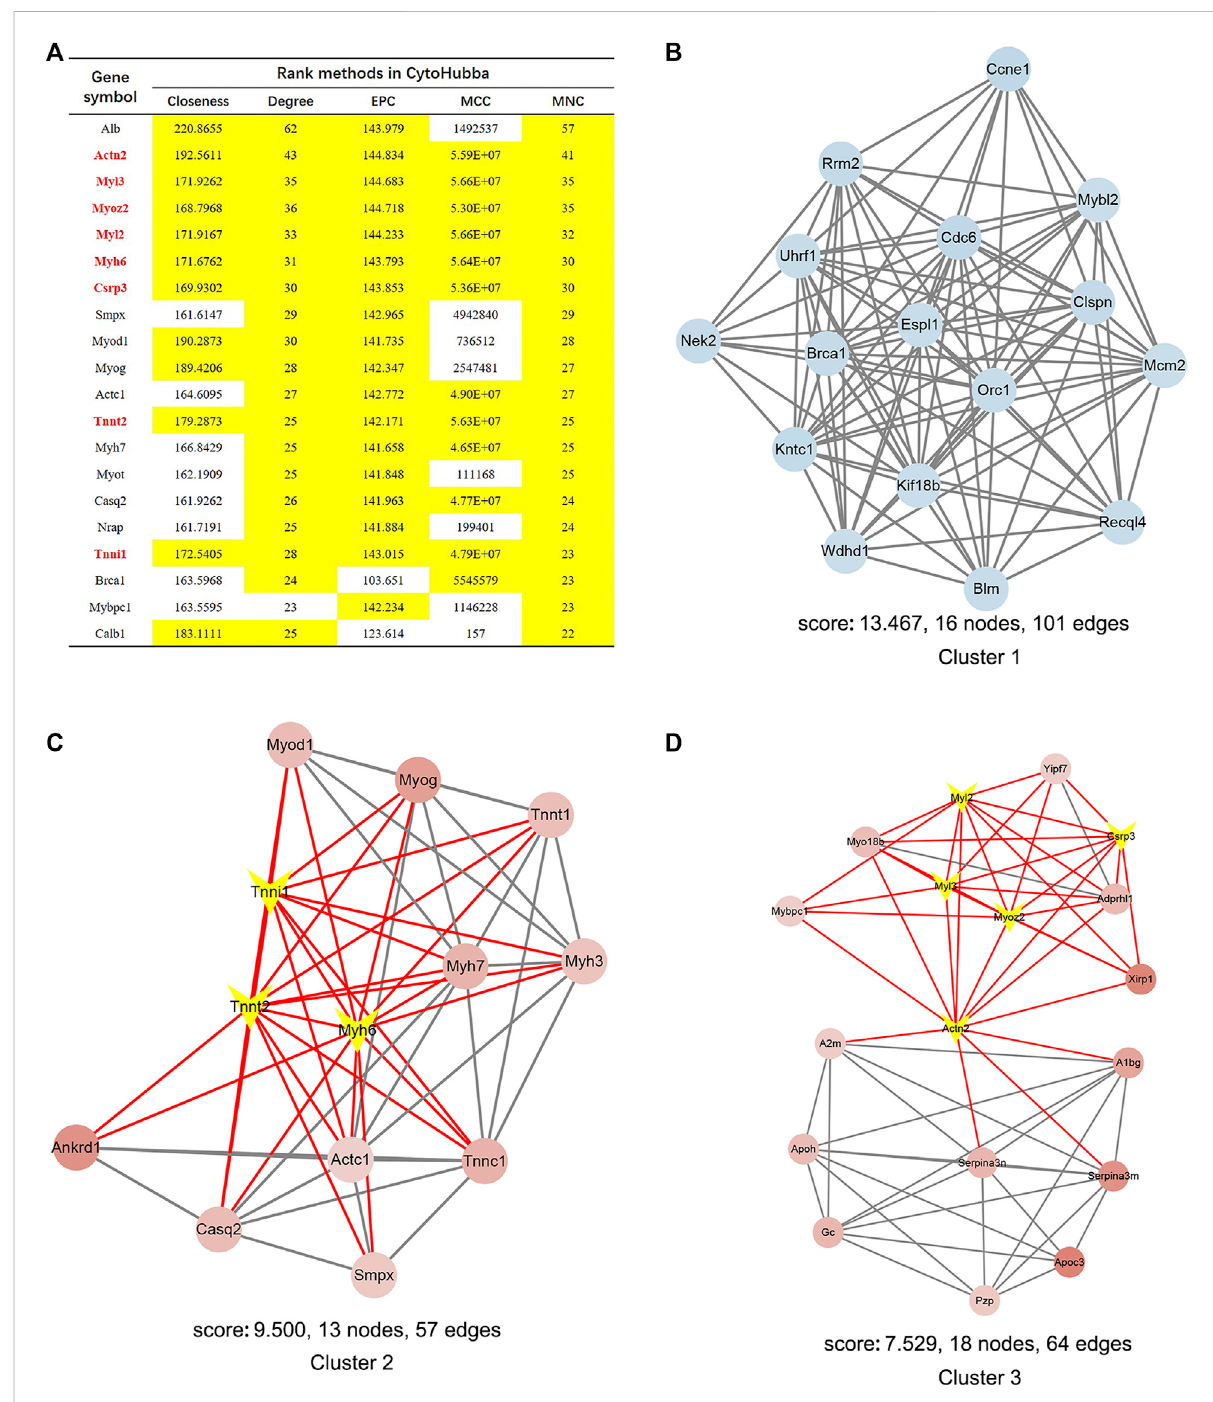
FIGURE 9 Identi fi cation of hub genes and essential gene cluster modules in the PPI network of DEGs in the SRP276872 dataset (A) The hub genes identi fi ed by fi ve algorithms, including degree, MCC, MNC, EPC, and closeness. Those marked yellow indicate that their ratings rank in the top 20 of their respective algorithms (B – D) . The top three modules identi fi ed by MCODE. The V-shape in yellow indicates hub